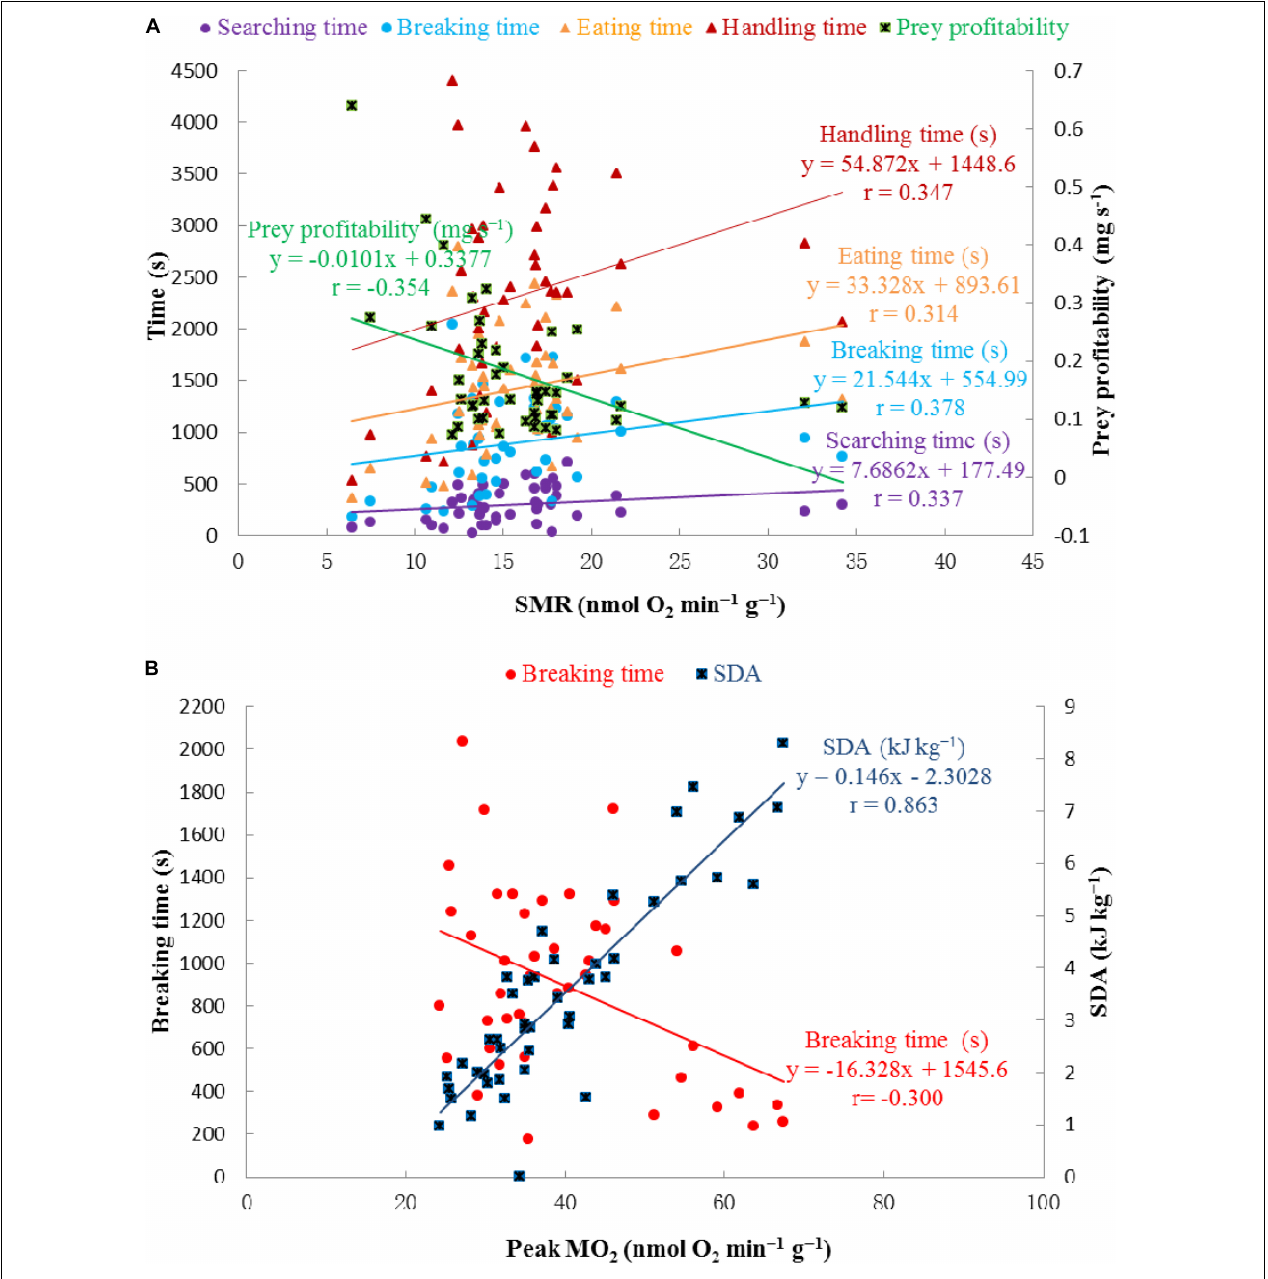
FIGURE 7 | Correlations between SMR (nmol O 2 min − 1 g − 1 ) and searching time, breaking time, eating time, handling time, prey profitability, respectively (A) and correlations between peak